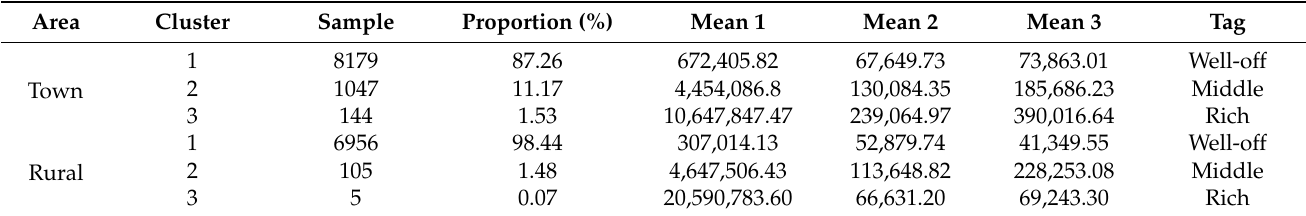
Table 12. Financial micro-data clustering of Chinese debt-free